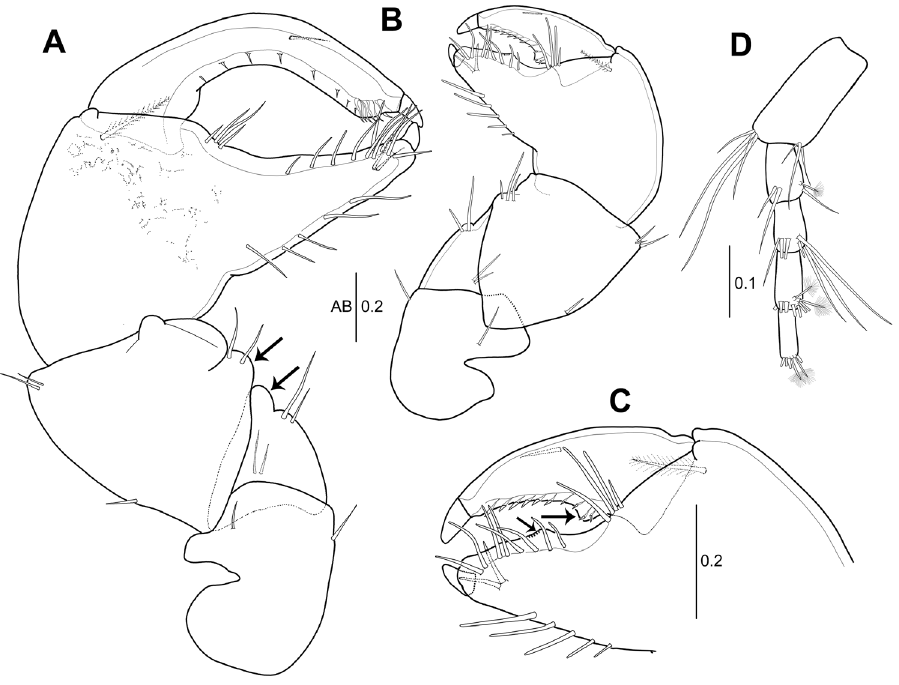
Figure 6. Hexapleomera ulsana sp. n., male allotype, A cheliped B–C male paratype B cheliped C cheliped chela D allotype male, uropod. Scale bars in